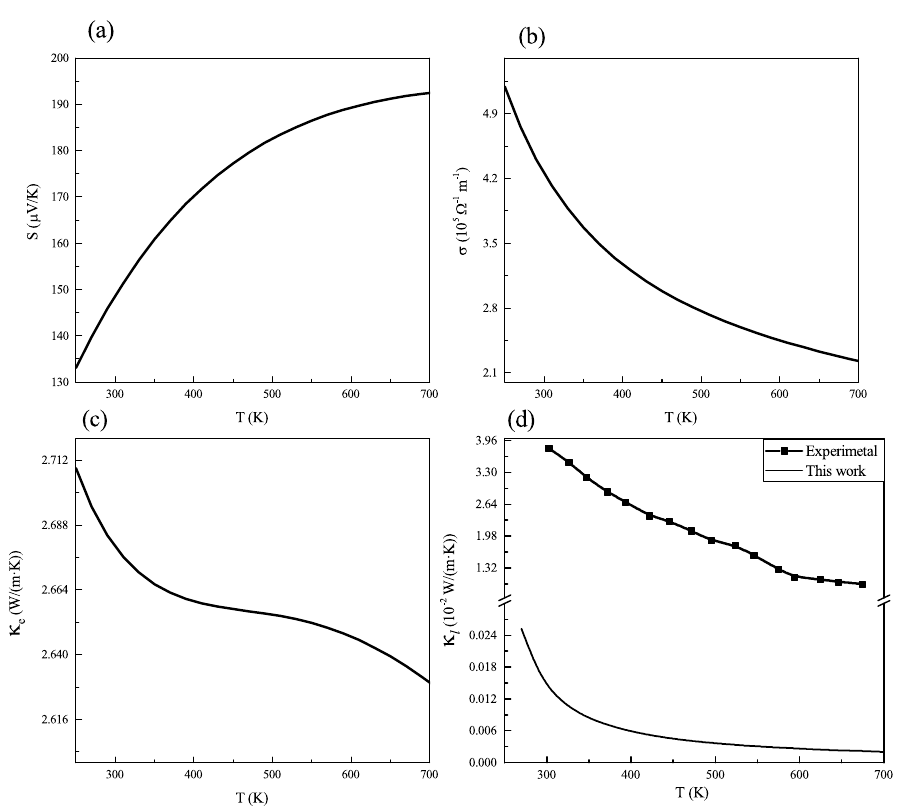
Figure 6. ( a ) Seebeck coefficient; ( b ) electrical conductivity; ( c ) electrical part of thermal conductivity; and ( d ) lattice thermal conductivity as functions of temperature kesterite Cu 2 ZnGeS 4